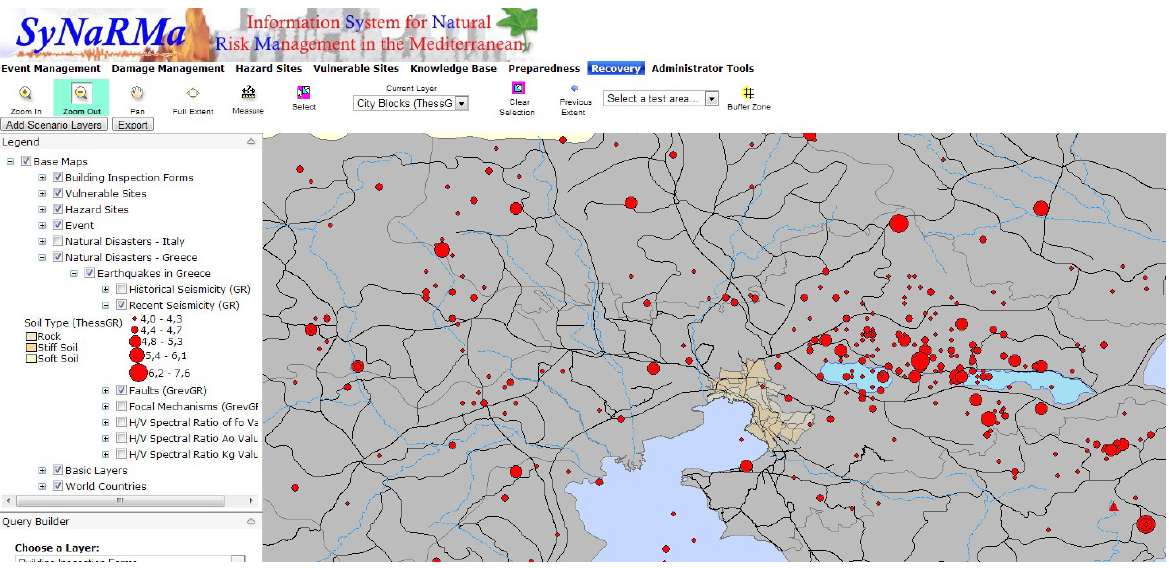
Figure 6. The Synarma system: A display of the broader area of the city of Thessaloniki along with information useful to the estimation of the vulnerability of structures (red dots represent the epicenters of earthquakes; the soil type at the city limits is also shown).